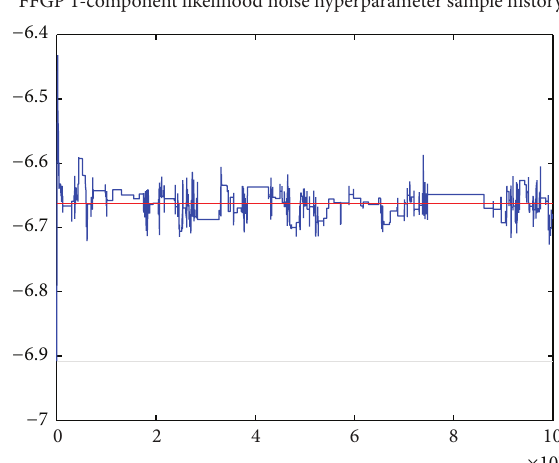
Figure 7: FFGP 2-factor 1-component likelihood noise hyperpa- rameter samples.